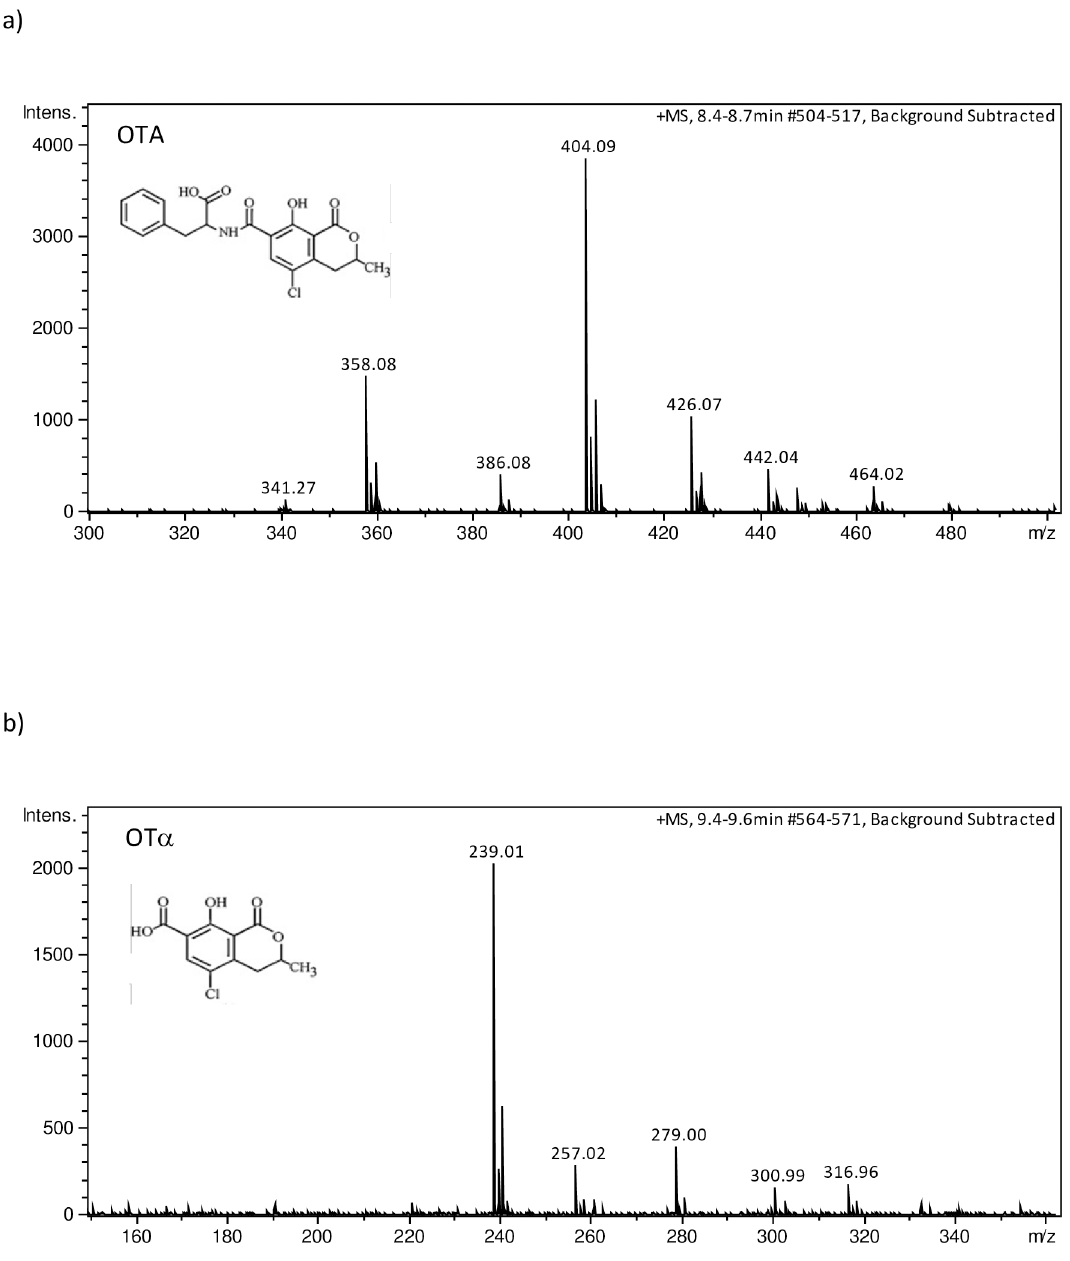
Fig 2. ESI(+)-MS spectraof (a) OTA (major ions: m / z 358.08[MH-HCOOH] + , m / z 404.09[MH] + and m / z 426.07 [MNa] + ) and (b) OT α (major ions: m / z 239.01 [MH-H2O] + , m / z 257.02 [MH] + and m / z 279.00 [MNa] + ).